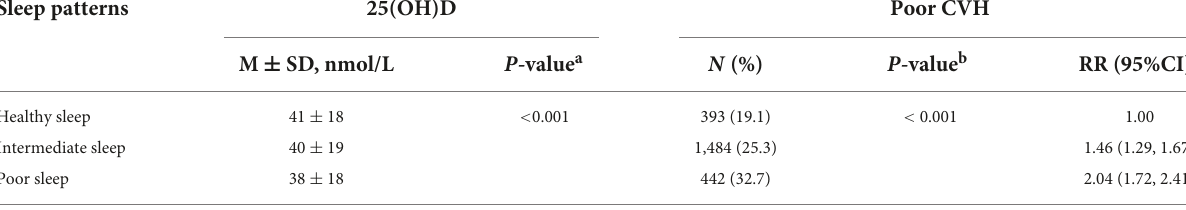
TABLE 3 Association of sleep patterns with serum 25(OH)D concentrations and poor CVH. Sleep